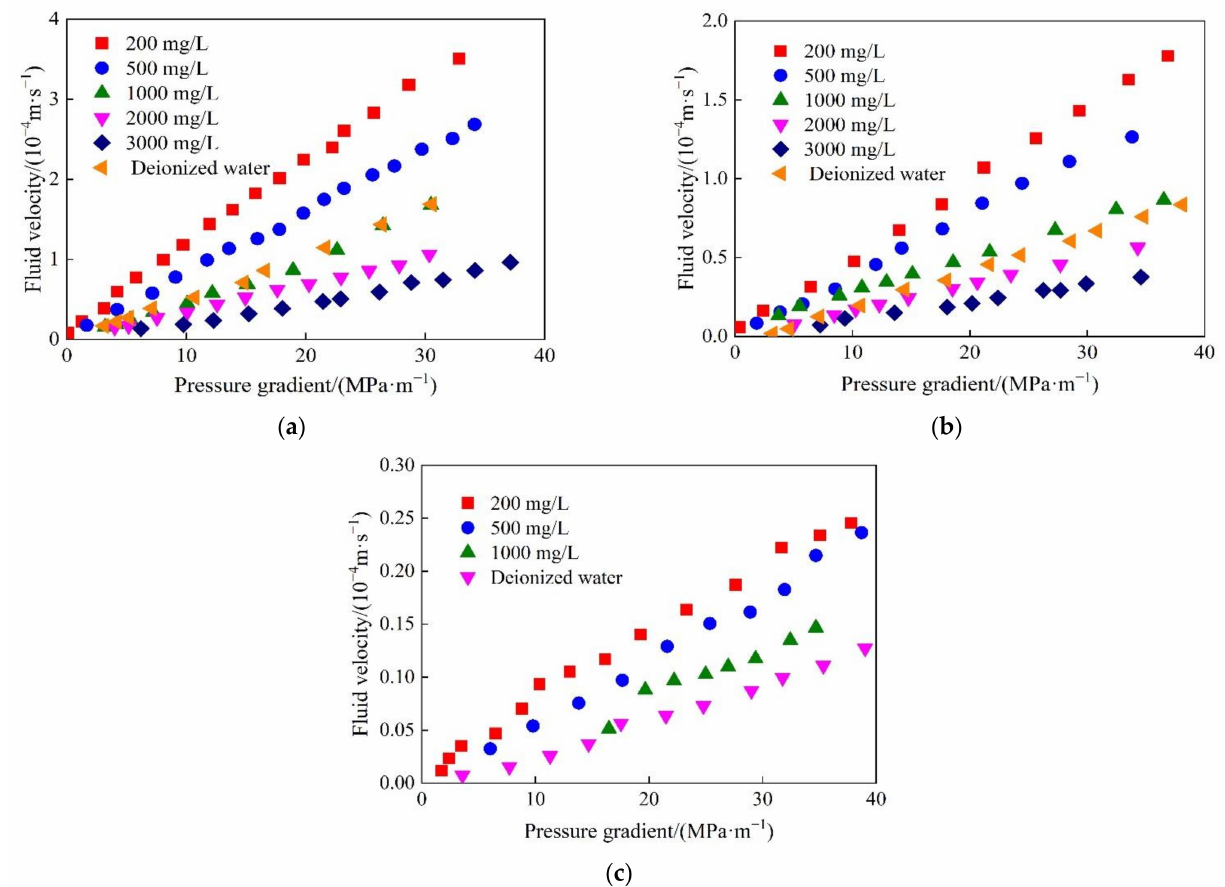
Figure 11. Flow velocity of SiO 2 /P(MBAAm- co -AM) polymeric nanoparticle solutions at different mass concentrations versus the pressure gradient in the microtubules with the inner diameters of 20 ( a ), 15 ( b ), and 10 ( c ) µ